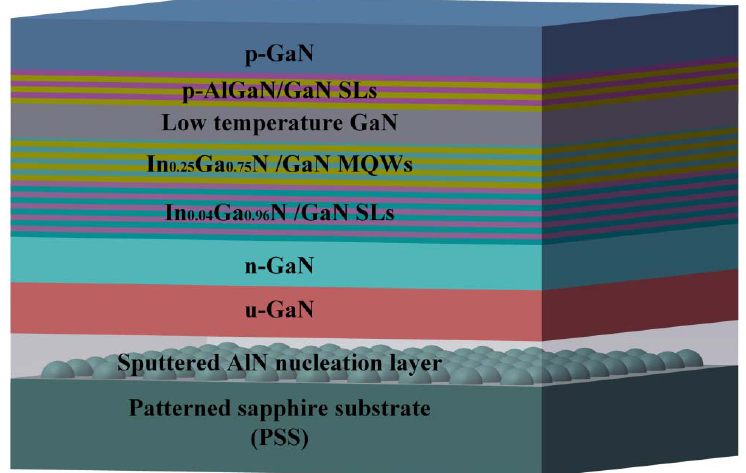
Figure 1. Schematic illustration of green light-emitting diode (LED) epitaxial structure. MQW, multiple quantum well; SL, superlattice.